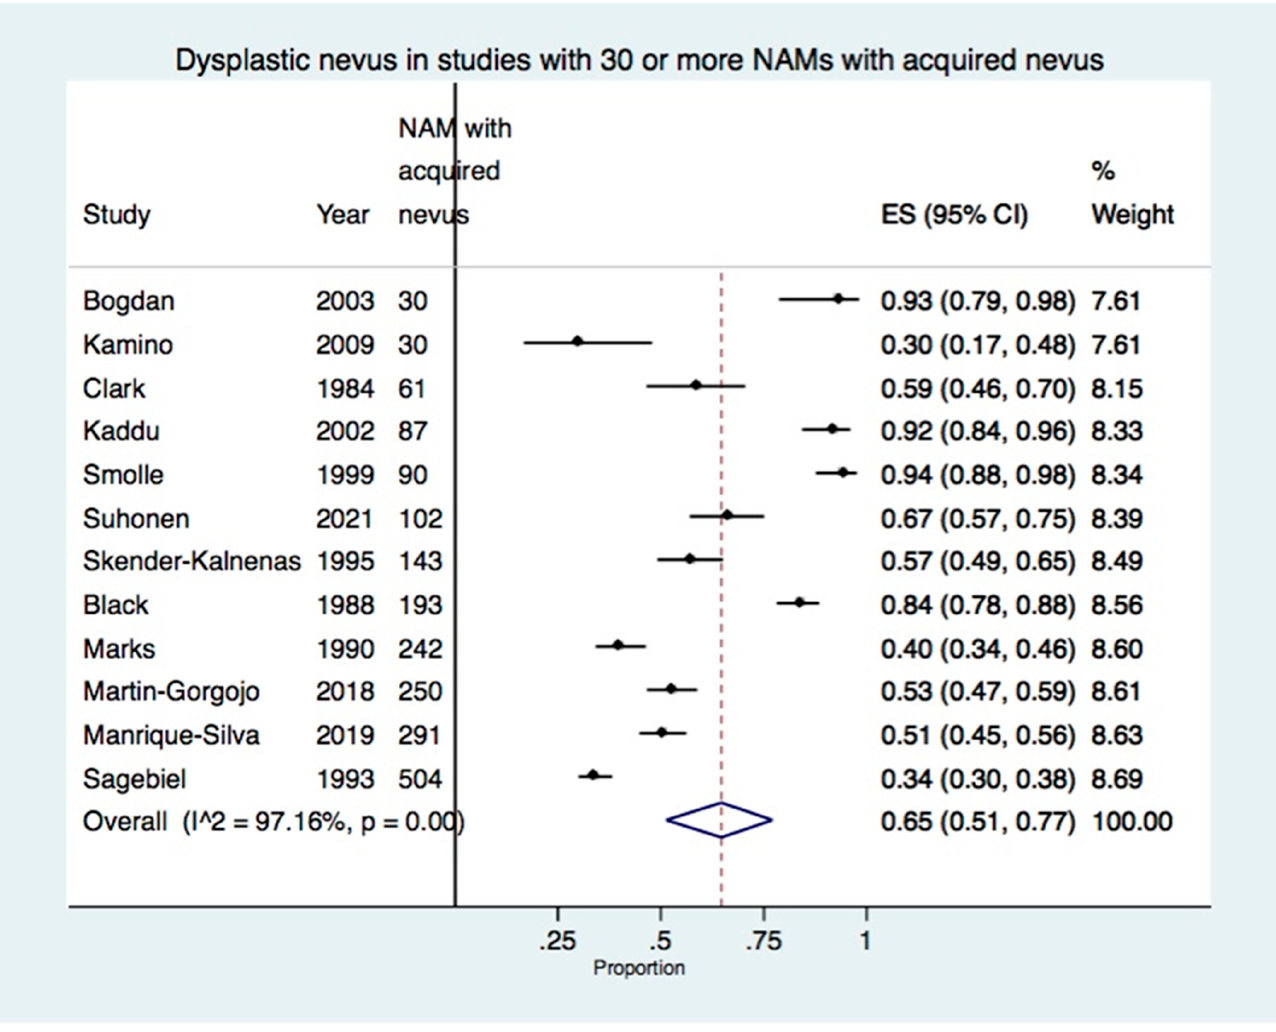
Figure 3. Forest plot showing the proportion of dysplastic nevus in studies with 30 or more NAMs developing in an acquired nevus (12 studies, 2023 NAMs with an acquired nevus). [7,22,23,26,27,30–32,35,38–40]